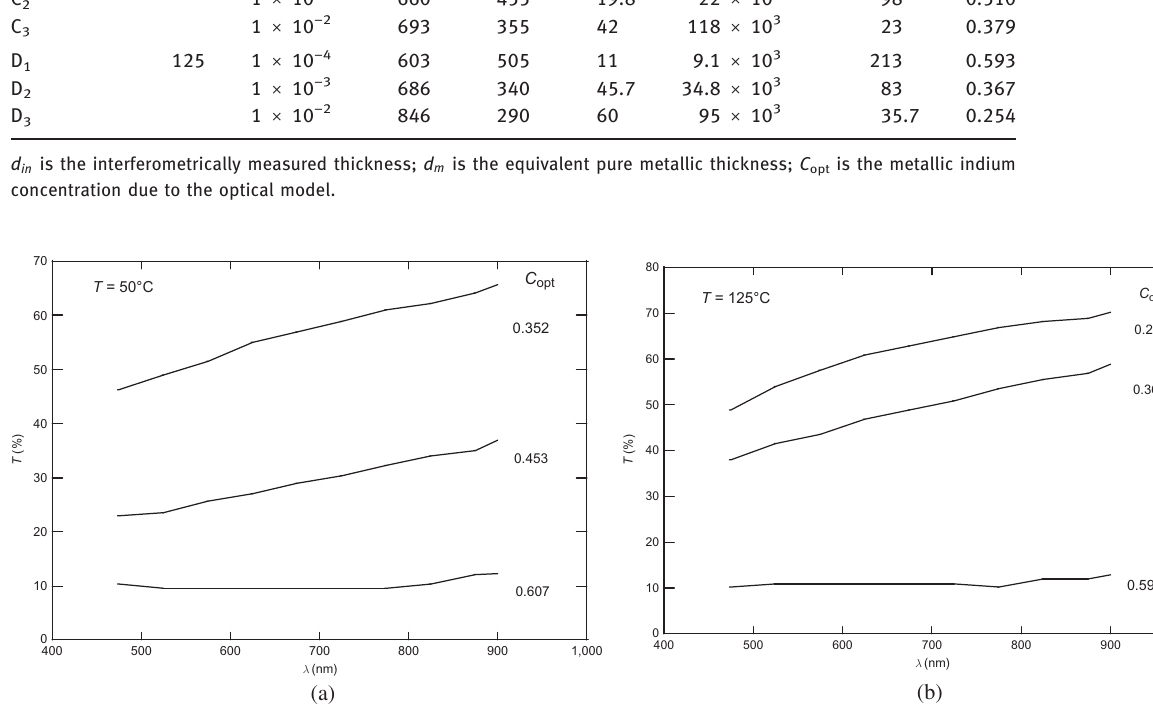
Figure 2: Optical transmittance of indium-embedded indium oxide films deposited at two different substrate temperatures for different C opt concentrations. C opt , metallic indium